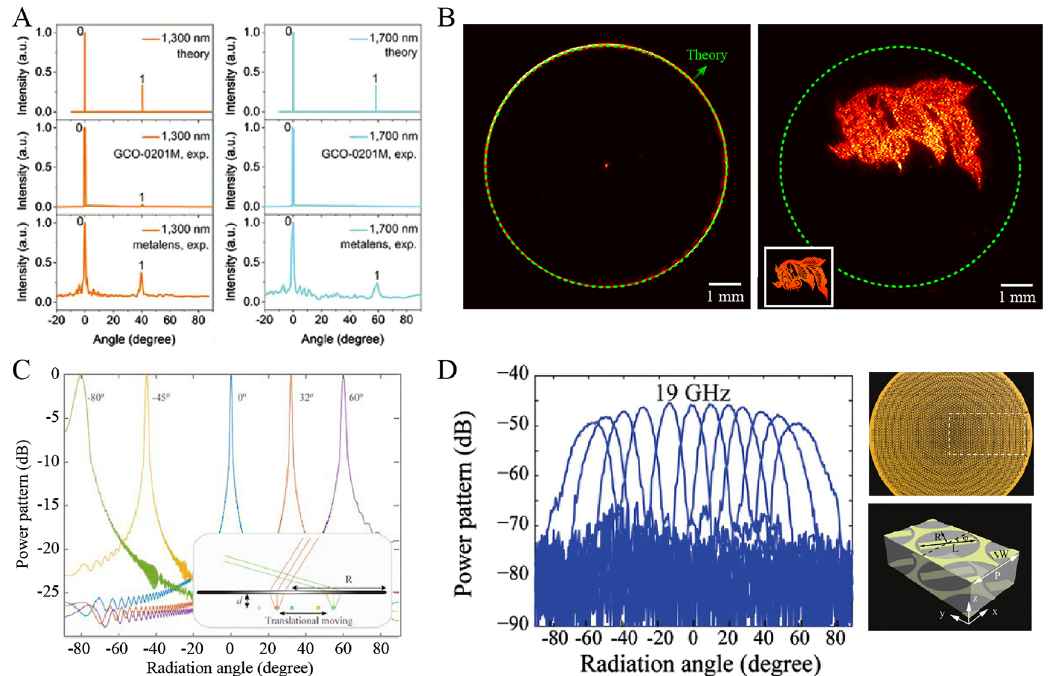
Figure 9: Applications of wide-angle metalenses for flat large-FOV imaging and beam steering. (A) Comparison of the 0th and 1st order diffraction at different wavelengths between the theoretical calculation and the corresponding measurement by Fourier transformation through GCO-0201M and the 1D quadratic metalens. Adapted with permission from ref. [89]. Copyright 2018, WILEY-VCH. (B) Spatial frequency measurement for a Bessel metalens (left) and meta-hologram (right) at 10.6 μ m wavelength using a 2D quadratic metalens. Adapted with permission from ref. [82]. Copyright 2021, WILEY-VCH. (C) Schematic and performance of beam steering by the quadratic metalens operating at the wavelength of 532 nm. Adapted with permission from ref. [74]. Copyright 2017, Optical Society of America. (D) Measured far- fi eld power patterns at the frequency of 19 GHz when a circularly polarized antenna is transversely shifted. Right insets show a perspective view of the quadratic metalens and the schematic of the unit cell. Adapted with permission from